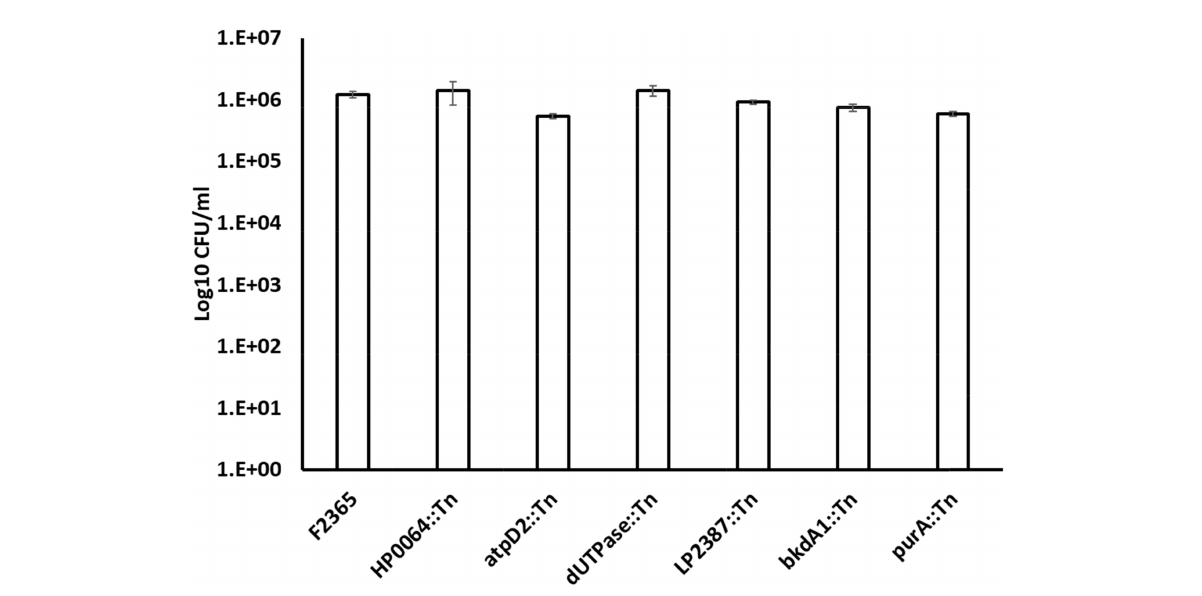
FIGURE4 The total number of CFU/ml of wild-type L . monocytogenes strain F2365 and Tn-mutant strains obtained without gentamicin treatment to J774.1 murine macrophage cells at 1 h post-infection. Numbers on the Y axis indicate bacterial quantities (CFU/ml). Statistical analysis did not show any significant differences ( P > 0.05). The experiment was repeated twice with three replicates each.